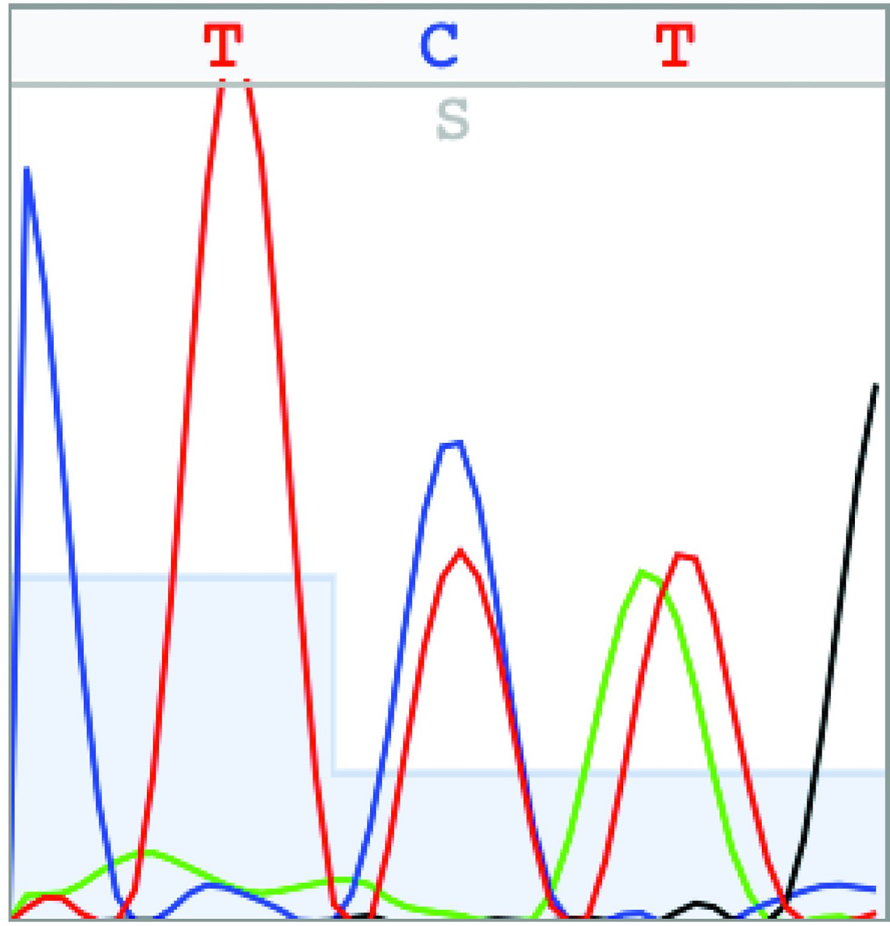
Fig 5. Chromatogram showing the SF-1014 (i.e., L1014S) heterozygote in the Conaway strain mosquitoes.